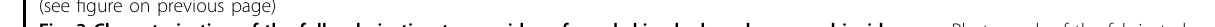
Fig. S14 for comparison of far- fi eld scattering patterns